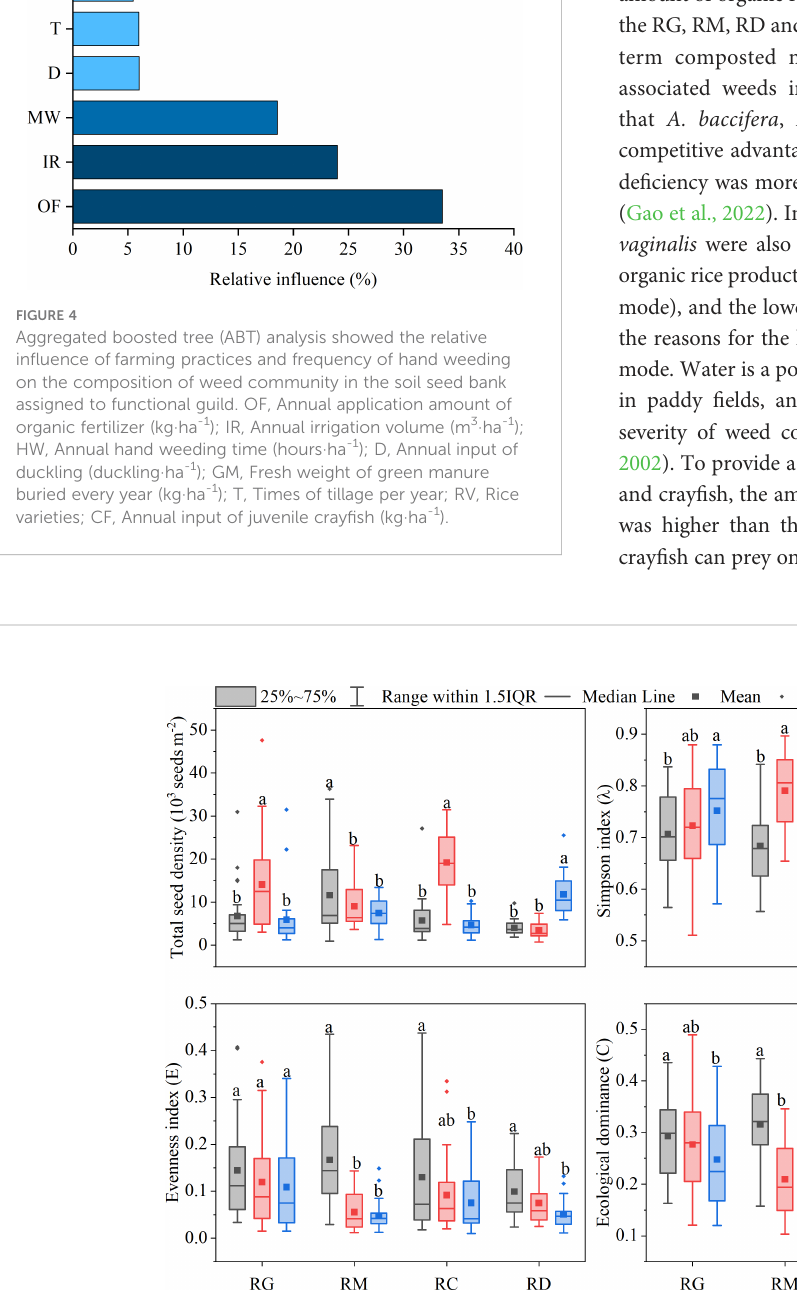
FIGURE 5 The variations of total seed density and diversity of weed communities in soil seed bank among consecutive planting years of different organic rice production modes. Gray box: consecutive planting for less 5 years; Red box: consecutive planting for more than or equal to 5 years but less than 8 years; Blue box: consecutive planting for more than or equal to 8 years. Boxes with the different lowercase letters are signi fi cantly different with different consecutive plantings years in the same organic production mode as determined by the LSD test at P<